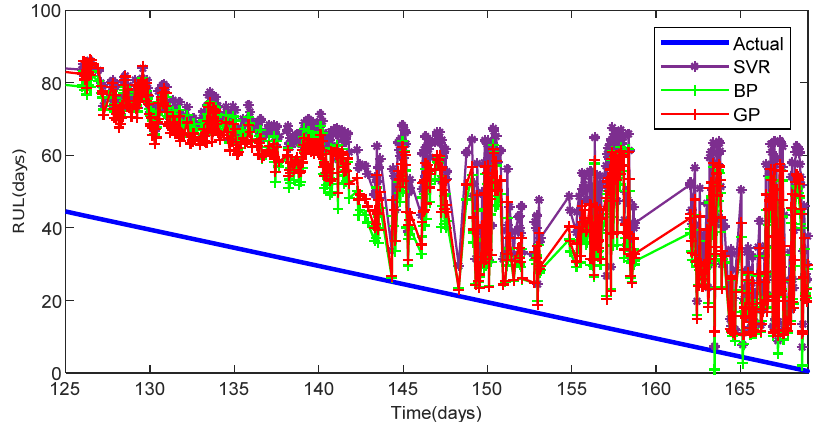
Figure 18. The prediction accuracy with different methods: the raw health indicators.